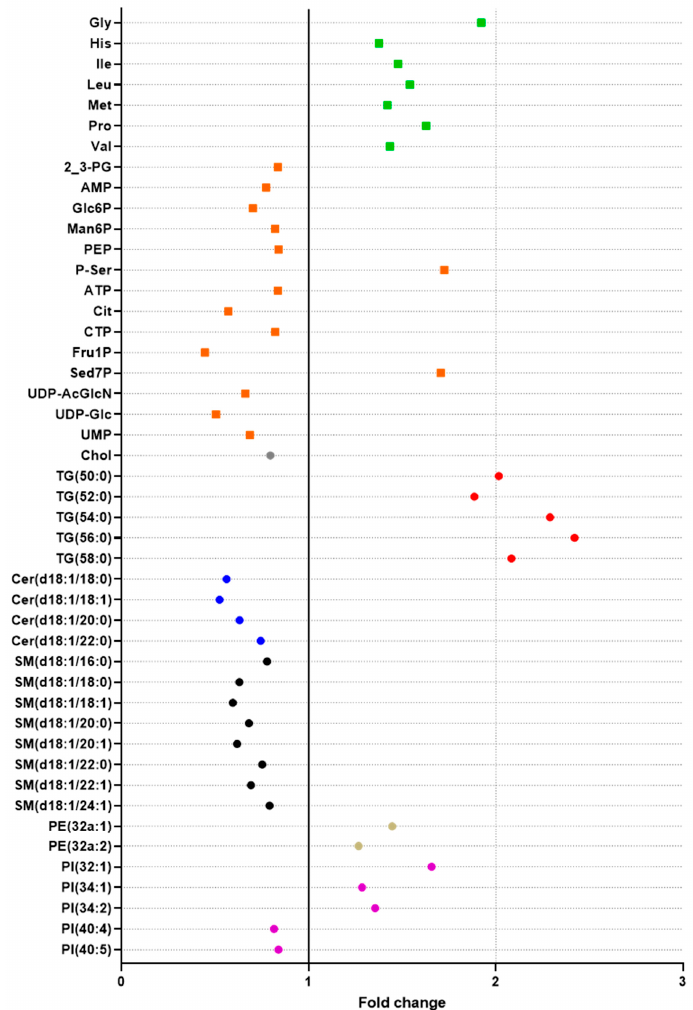
Figure 6. Effect of a high concentration of fenofibrate (450 µM) on HepaRG cells. Data were obtained with 18 replicates. t -tests were performed for each metabolite to compare non treated (DMSO) and treated (fenofibrate) cells (see Figure S3 in Supplemental Material). All significant polar metabolites ( ◼ ) and lipids ( ⬤ ) are represented in this figure as fold change. Different colors were used to represent Amino acids (green), energy metabolites (orange), Cholesterol (grey), TG (red), Ceramides (blue), sphingomyelin (black), PE (brown), and PI (purple). Fold changes were obtained by dividing the means obtained for fenofibrate treatment by the means obtained for DMSO exposure. Increased metabolites in fenofibrate conditions are shown on the right (fold change > 1), and decreased metabolites in fenofibrate conditions are shown on the left (fold change < 1). glycine (Gly), phosphoserine (P-Ser), sedoheptulose-7-phosphate (Sed7P), proline (Pro), leucine (Leu), isoleucine (Ile), valine (Val), methionine (Met), histidine (His), phosphoenolpyruvate (PEP), adenosine triphosphate (ATP), 2,3-bisphosphoglycerate (2_3PG), cytidine triphosphate (CTP), mannose-6-phosphate (Man6P), cholesterol (Chol), adenosine 5 (cid:48) -monophosphate (AMP), glucose-6-phosphate (Glc6P), uridine 5 (cid:48) -monophosphate (UMP), uridine diphosphate acetylglucosamine (UDP-AcGlcN), citrate (Cit), uridine diphosphate glucose (UDP-Glc), fructose-1-phosphate (Fru1P), triglycerides (TG), ceramides (Cer), phosphatidylethanolamine (PE), sphingomyelins (SM), phosphatidylinositols